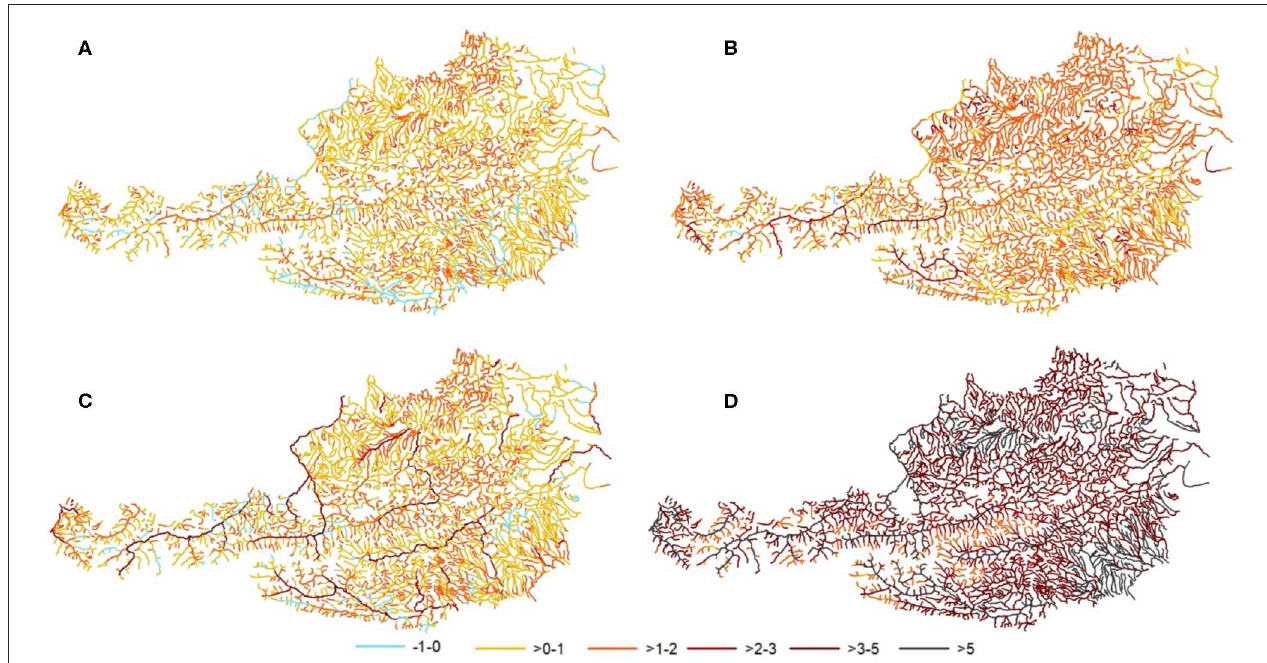
FIGURE 4 | Signal of change of the water temperature model for WTQ95 compared to the current conditions (2000–2011) in degree Celsius ( ◦ C) for (A) near future RCP4.5, (B) far future RCP4.5, (C) near future RCP8.5, and (D) far future RCP8.5.